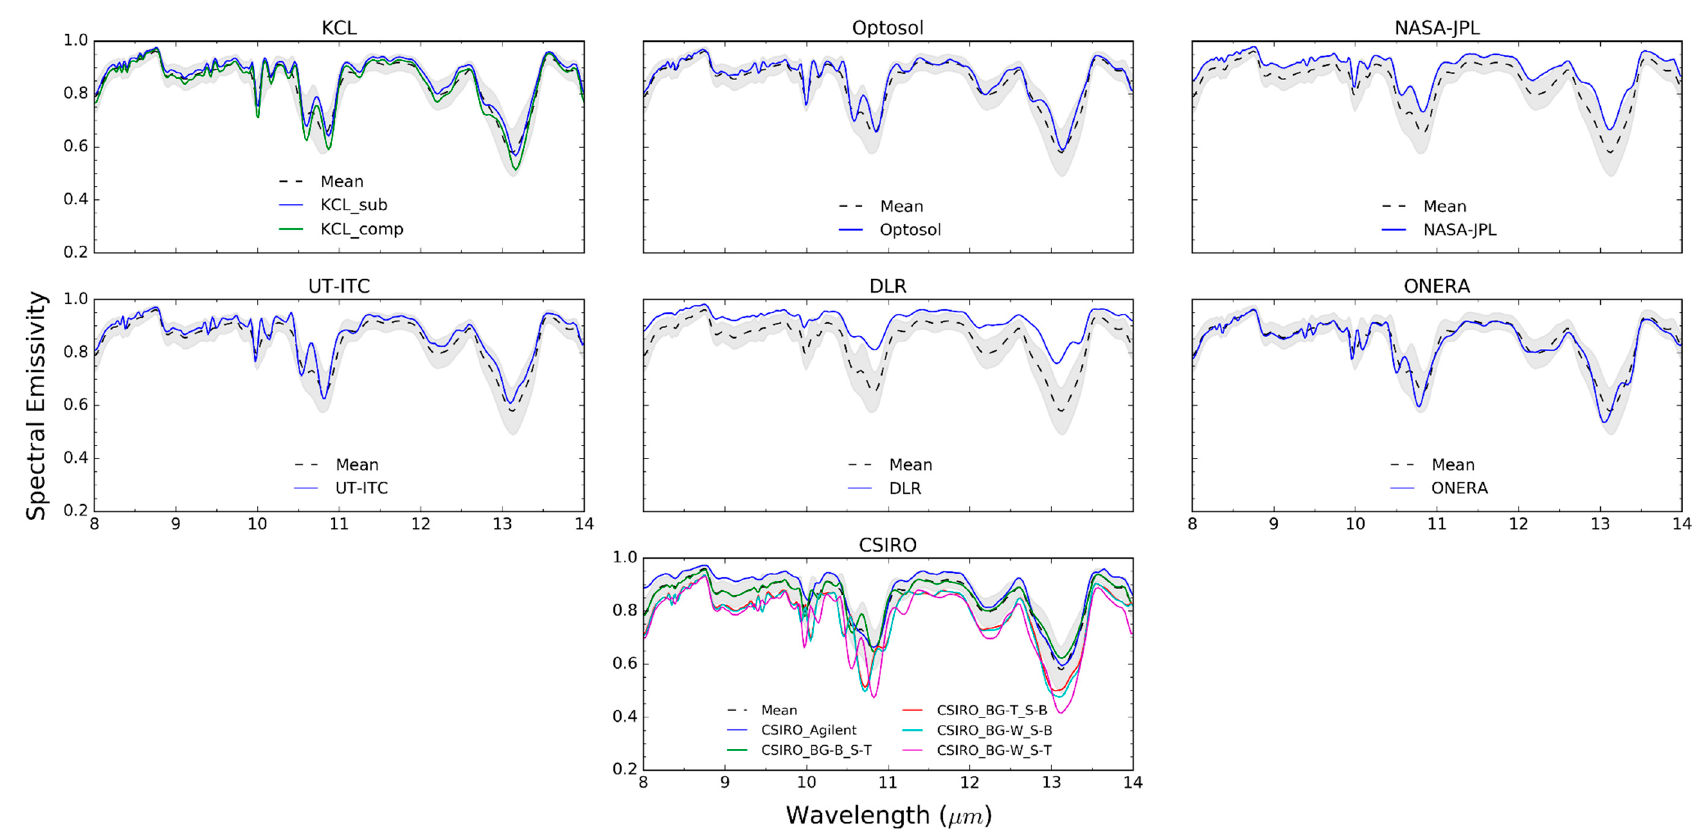
Figure 7. Measured SEs for Sample 1 from each participating laboratory, derived at a 4 cm − 1 spectral resolution across 8–14 µ m and presented against the mean and standard deviation of all SE measurements, shown as the black dashed line and grey shaded area respectively.